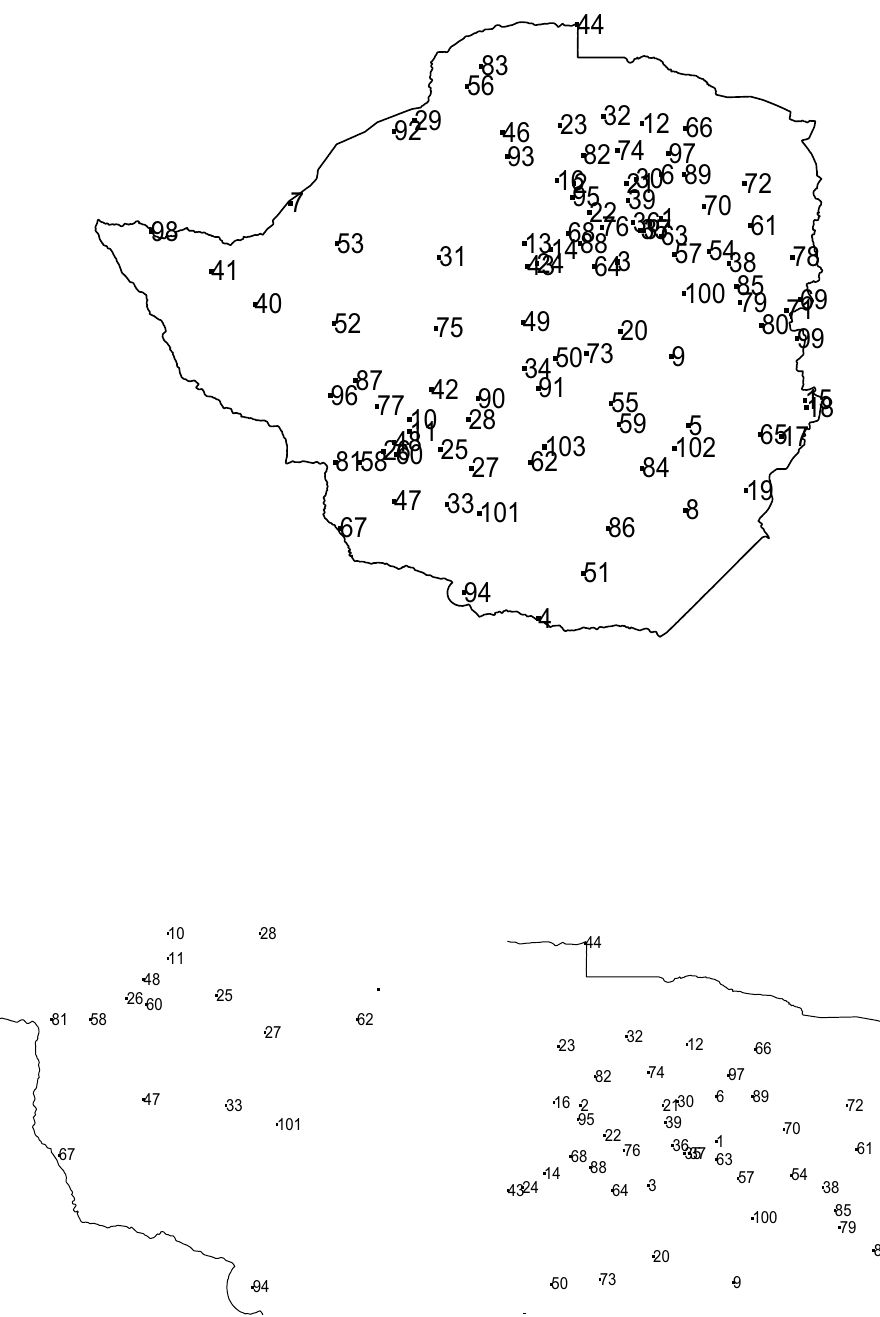
Figure 1. Location of stations as identified by the station numbers in Table 1 (top); Location of stations around Bulawayo, station number 10 (bottom left); Location of stations around Harare, station number 35 (bottom right). ggplot2 version 3.3.5, https:// cran.r- proje ct. org/ web/ packa ges/ ggplo t2/ index. html was used for